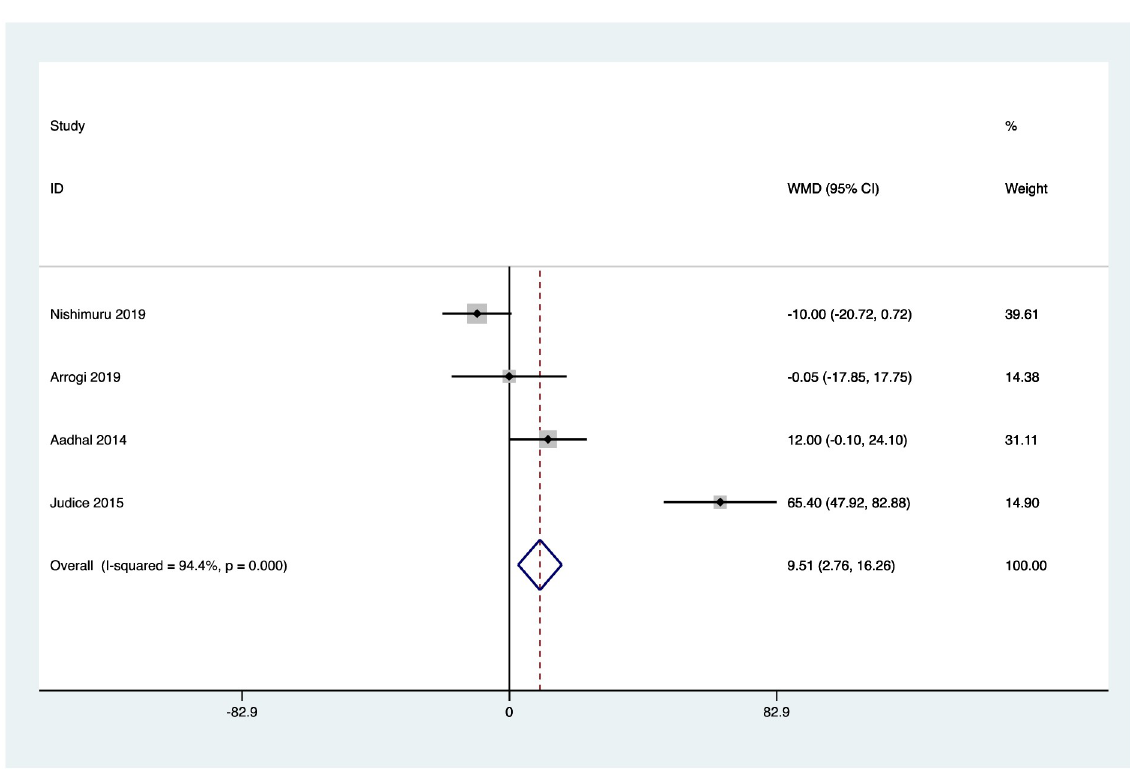
Fig 4. activPAL mean daily stepping time (minutes). Heterogeneity chi-squared = 53.25 (d.f. = 3) p = 0.000; I-squared (variation in WMD attributable to heterogeneity) = 94.4%; Test of WMD = 0: z = 2.76 p = 0.006.